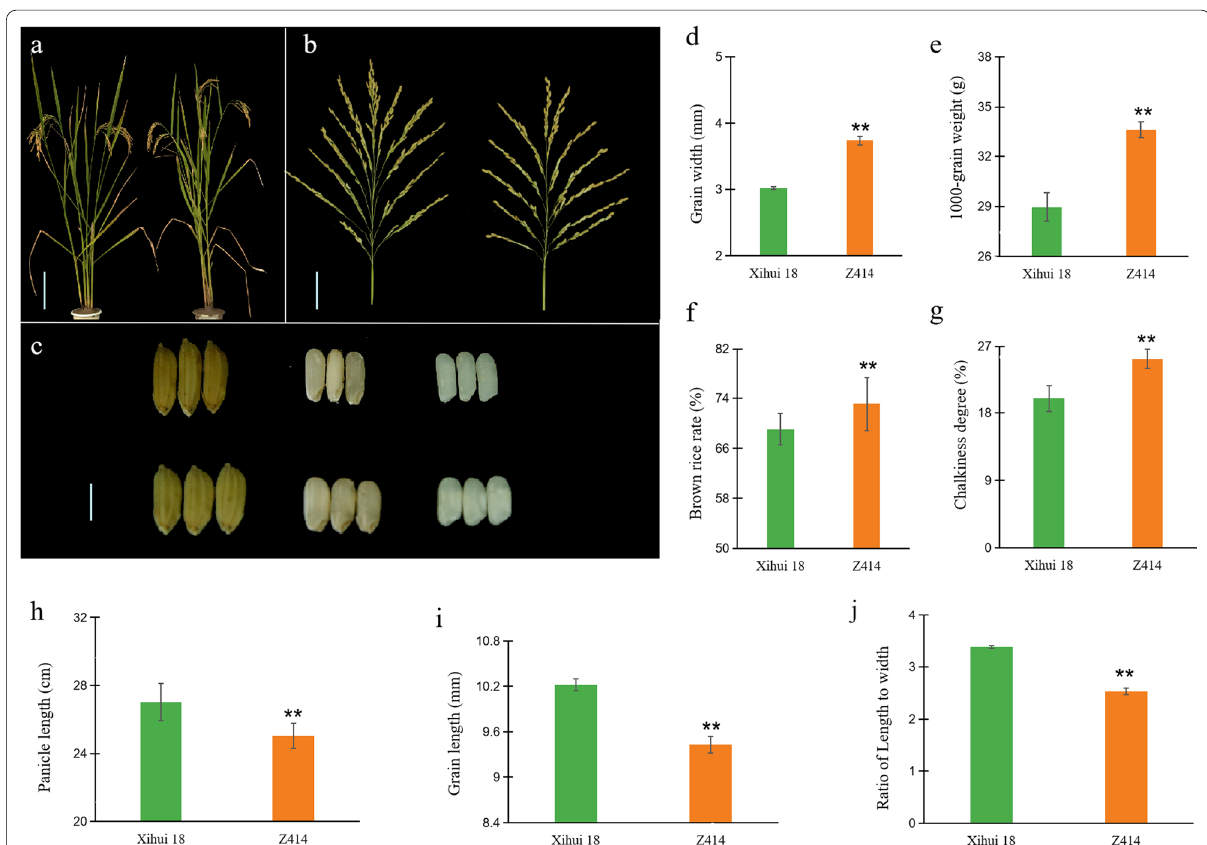
Fig. 2 Phenotypes of Xihui 18 and Z414. a Plant types of Xihui 18 and Z414. b Panicles of Xihui 18 and Z414. c Grains, brown rice, and polished rice of Xihui 18 and Z414. Bars represent 20 cm in a , 5 cm in b , and 5 mm in c . d – j Statistical analysis of the differences in seven traits between Z414 and Xihui 18, in order as grain width ( d ), 1000-grain weight ( e ), brown rice rate ( f ), chalkiness degree ( g ), panicle length ( h ), grain length ( i) , ratio of grain length to width ( j ). * and ** indicate significant differences at the 0.05 and 0.01 level,